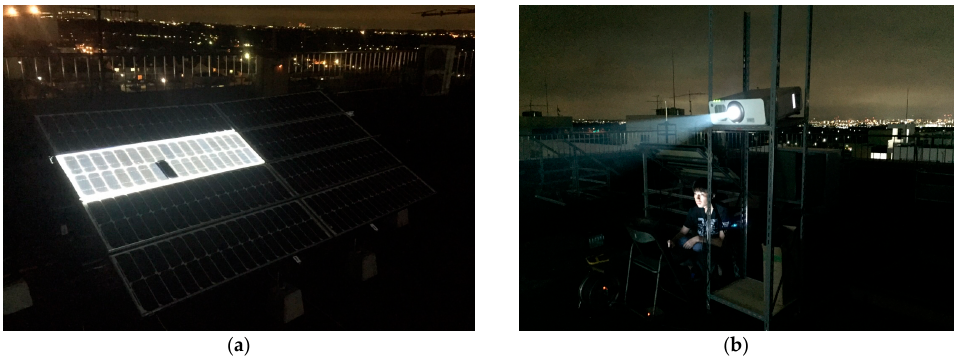
Figure 14. Pictures of real-field detection. ( a ) An example of shaded cell; ( b ) Projector used in experiment, one crew member is operating the monitor software.